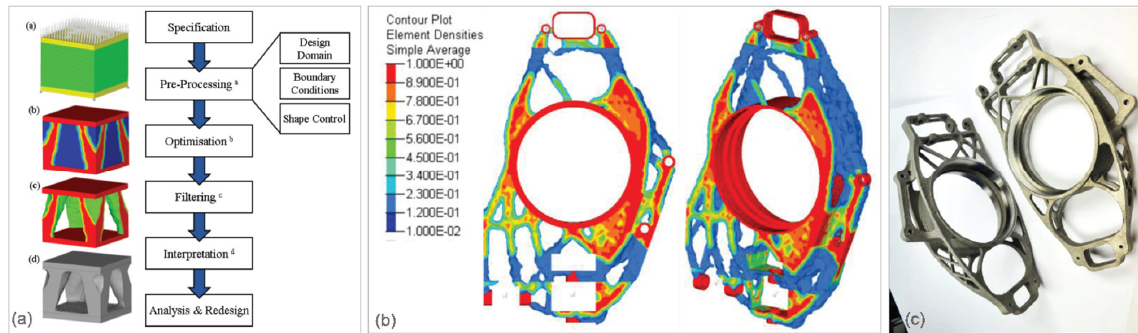
Figure 5. A concept of lightweight design through topology optimization: ( a ) topology optimization work-flow, with the example of a 75% mass reduction for a cube under a compressive load on the top face; ( b ) post-optimization result, showing element pseudo-densities of >0.25; and ( c ) structural member of the vehicle suspension assembly after EBM manufacturing and CNC machining [25].